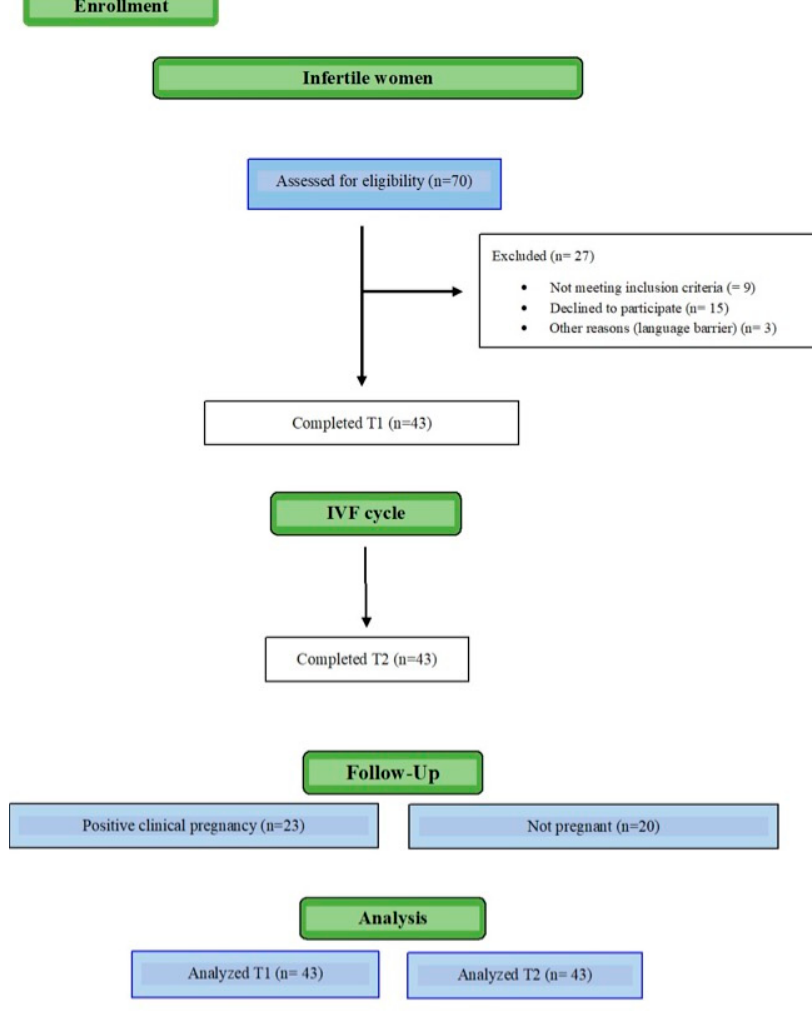
Figure 1. Participant flow diagram.